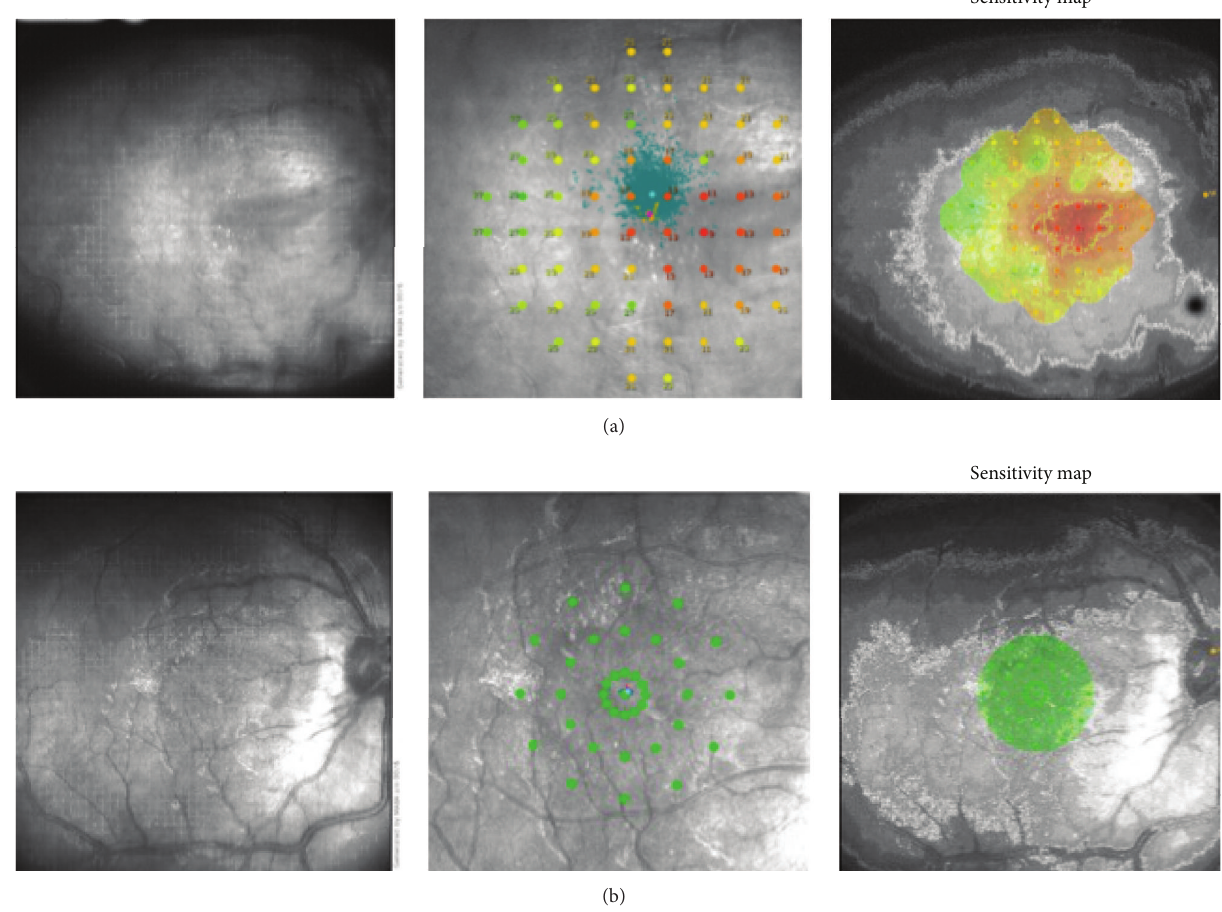
Figure 2: Fundus microperimetry (Macular Integrity Assessment, MAIA, CenterVue, Padova, Italy) of the right eye: initial exam, at presentation, showing decreased retinal sensitivity (a). Following ranibizumab treatment, marked improvement in retinal sensitivity (b).